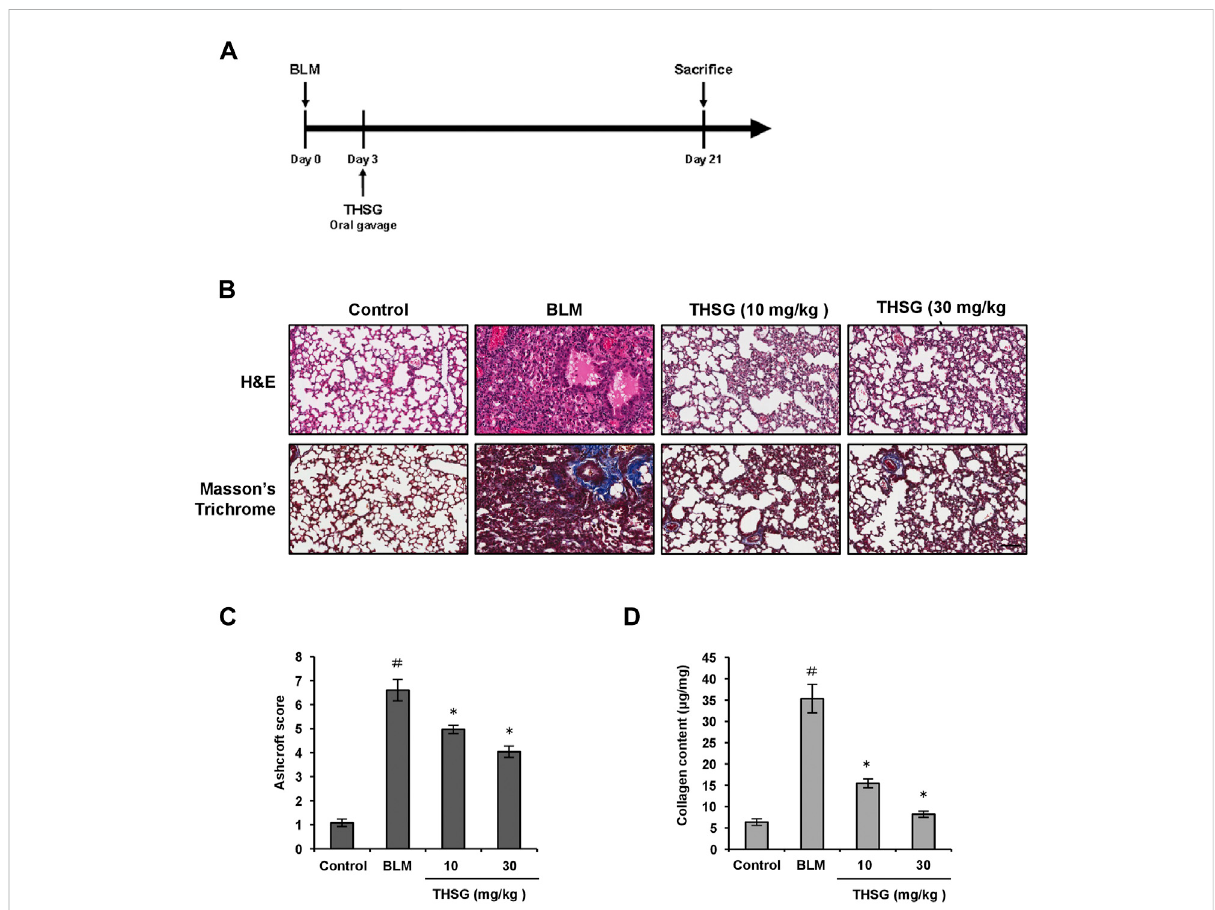
FIGURE 1 Effect of THSG on BLM-induced pulmonary fi brosis in mice. (A) Experimental design: Mice were intratracheally injected with BLM (1.5 mg/kg in 50 μ L of PBS) at day 0. The treatment groups received orally with THSG (10 or 30 mg/kg) once a day, fi ve times a week from day 3 to day 20. Mice were sacri fi ced on day 21 and lung samples were collected for further analysis. (B) Representative photographs of H&E and Masson ’ s trichrome staining of lung tissuesections in the indicated groups. Scale bar: 100 μ m. (C) Ashcroft fi brosis scores were used to evaluate the degree of lung fi brosis. (D) Detection of collagen content in the lung tissues of mice from different experimental groups by the Sircol collagen assay. Data are represented as themean ± SEM ( n = 6in each group). # p < 0.05 compared with vehicle-treated control group. * p < 0.05 compared with BLM